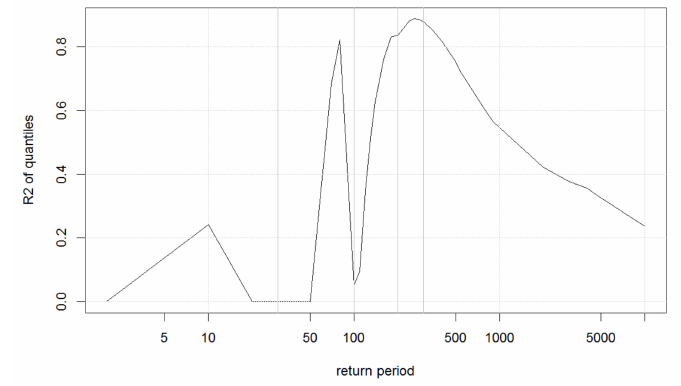
Figure A12. Correlation ( R 2 ) for the relation between the EVA quantiles and the HORA quantiles as function of return period (grey vertical lines correspond to the 30, 100, 200, and 300-year return